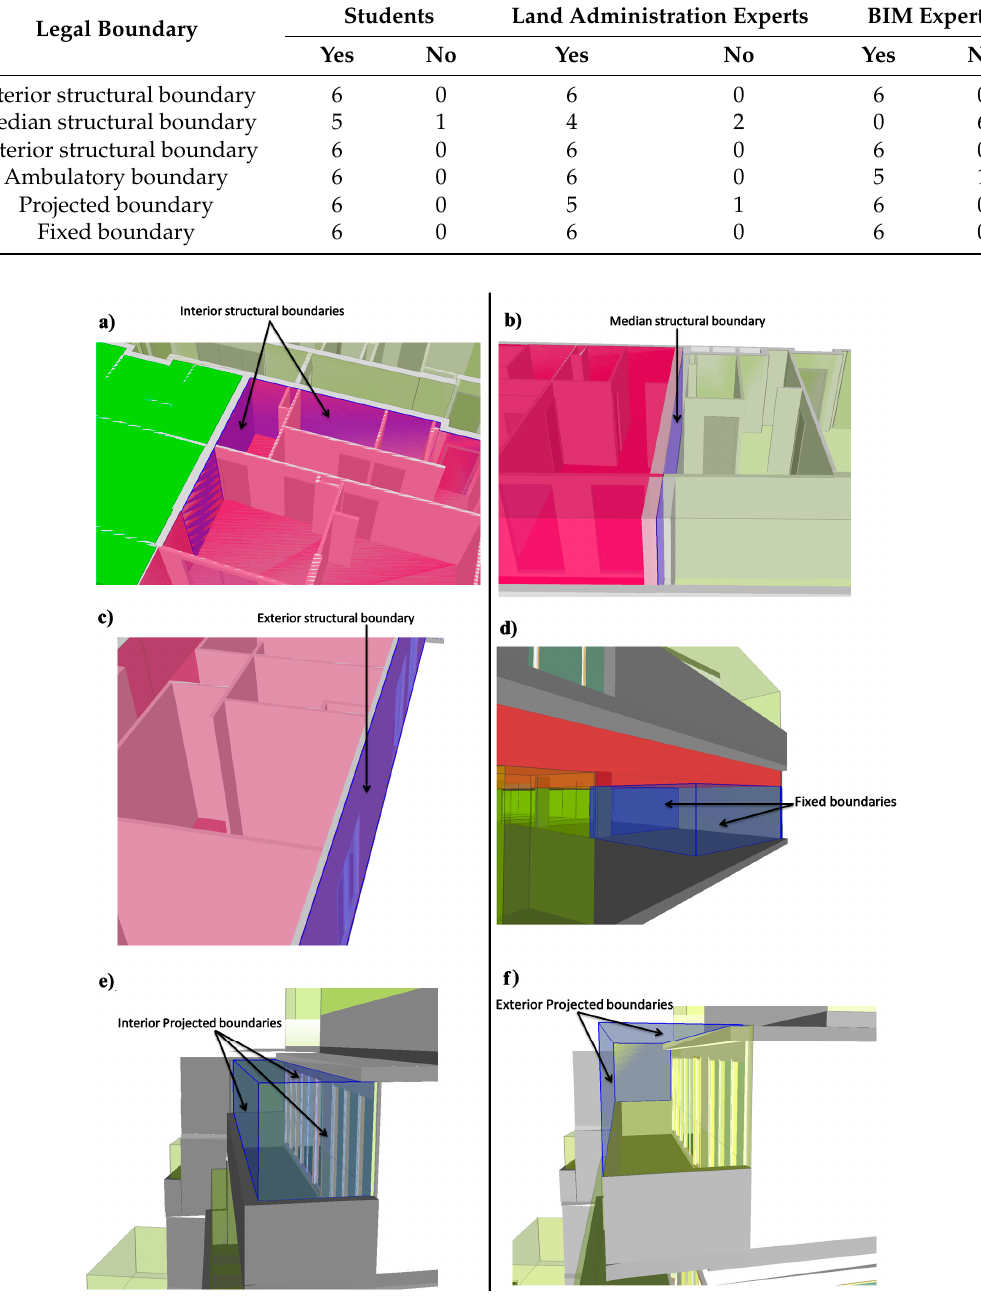
Figure 13. Examples of legal boundaries represented in the integrated model: ( a ) Internal wall boundaries; ( b ) Median wall boundary; ( c ) External wall boundary; ( d ) Fixed Boundaries of a parking space; ( e ) Internal projected boundaries; ( f ) External projected boundaries